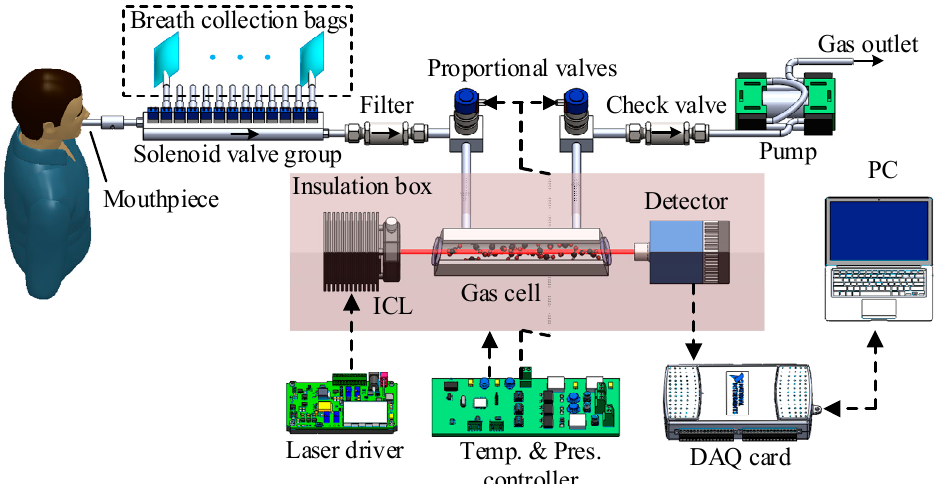
Figure 2. Schematic diagram of the developed sensor for simultaneous measurement of 12 C 16 O 2 , 13 C 16 O 2 , 18 O 12 C 16 O and 17 O 12 C 16 O in human